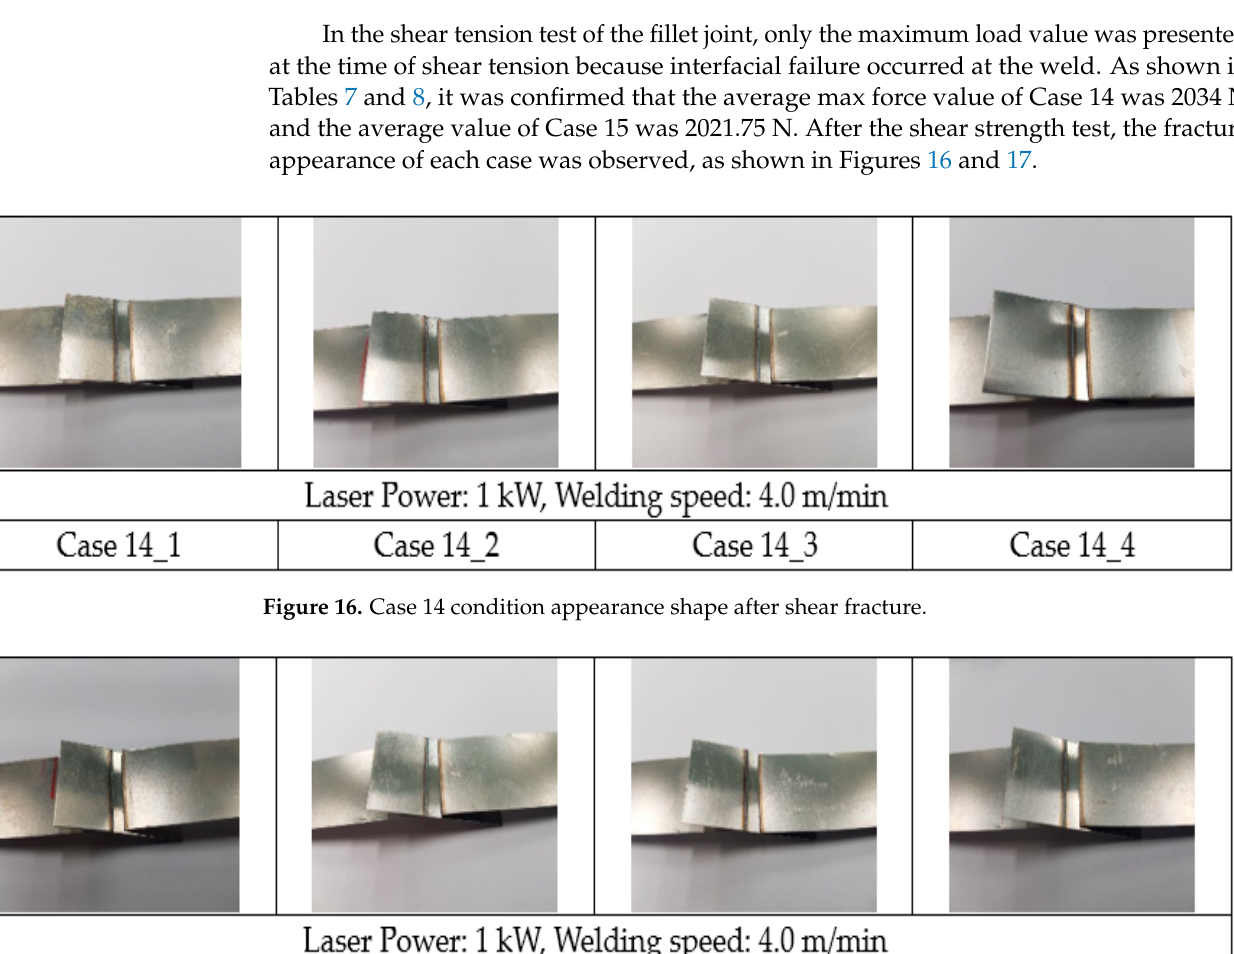
Figure 18. Schematic diagram of thermocouple attachment location.